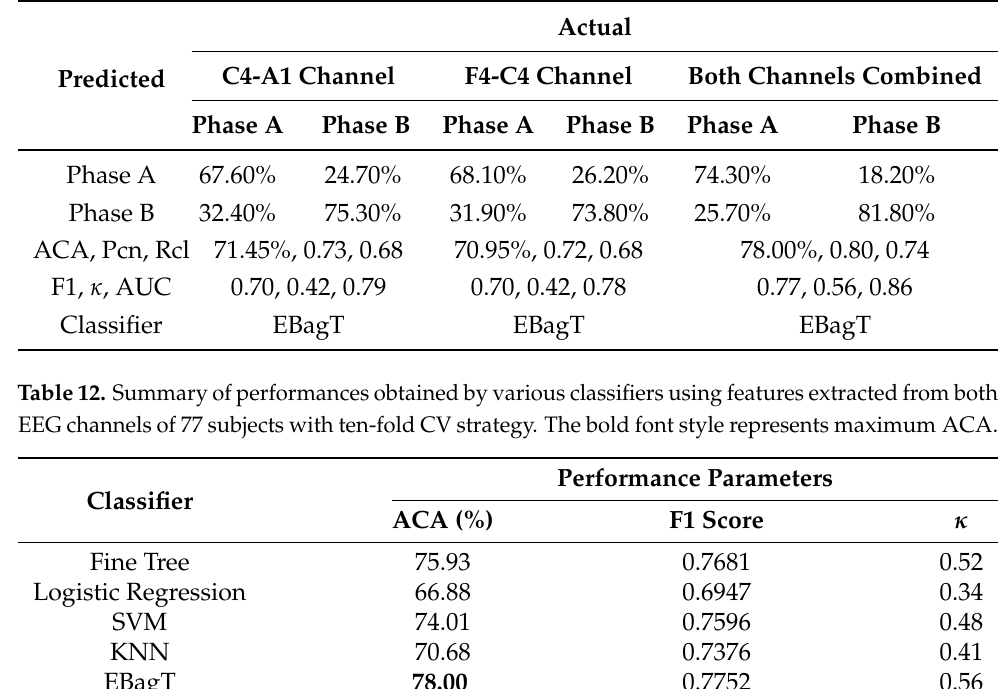
Table 11. Classification performance for all subjects combined.